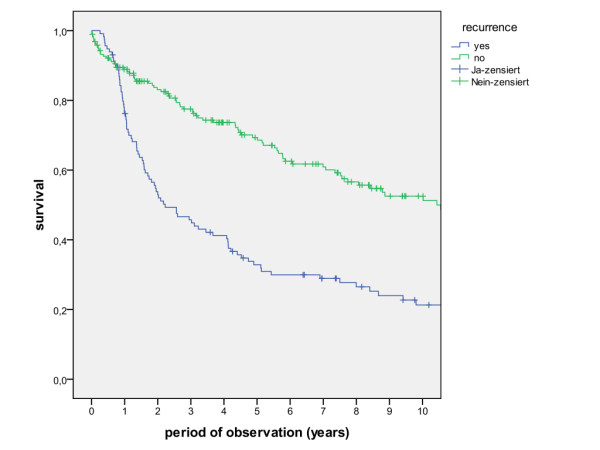
Suvival of patients with and without locoregional tumour recurrence (log rank p < 0.001).